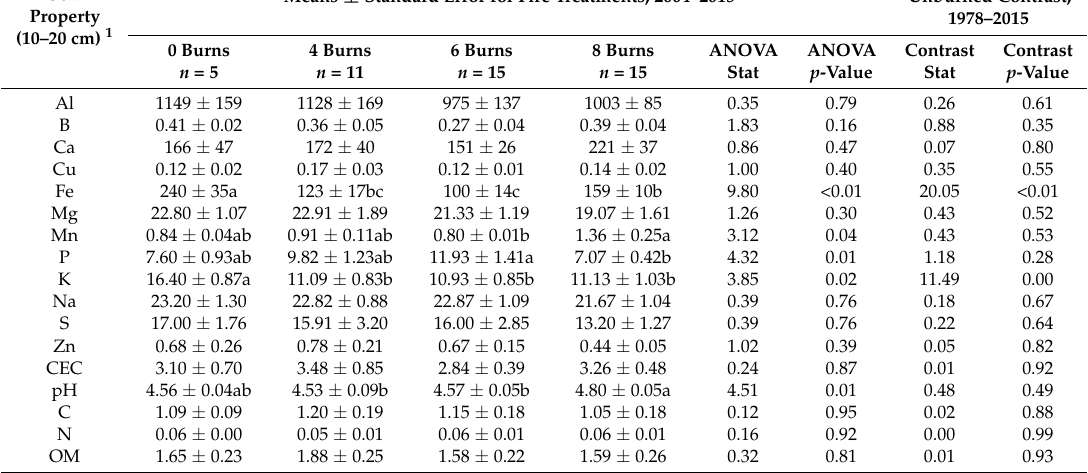
Table 3. Soil chemical property means ( ± standard error) at the 10–20 cm soil depth based upon fire frequency from 2004 to 2015 and linear contrast results for fire inclusion from 1978 to 2015 at the Tom Yawkey Wildlife Center, Georgetown, SC, USA. Means with different lowercase letters are statistically different at α =